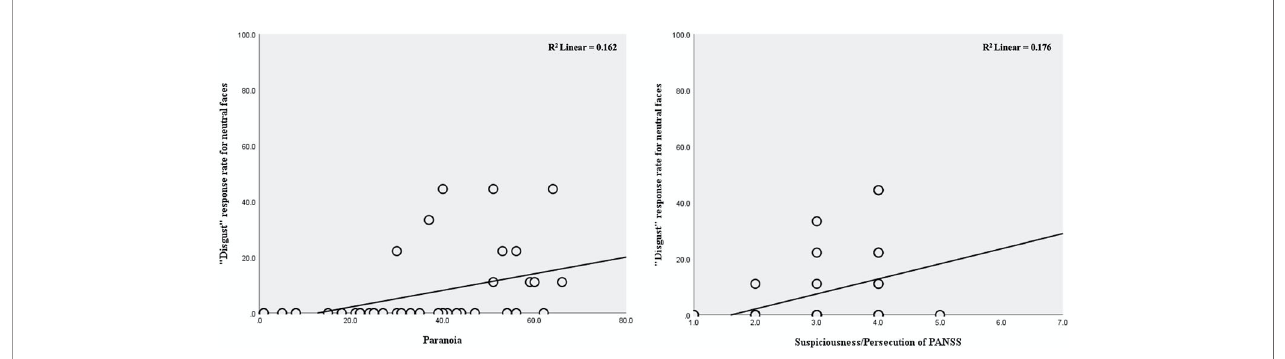
FIGURE 2 | Relationships between “ disgust ” response rate for neutral faces and paranoia level in individuals at ultra-high risk